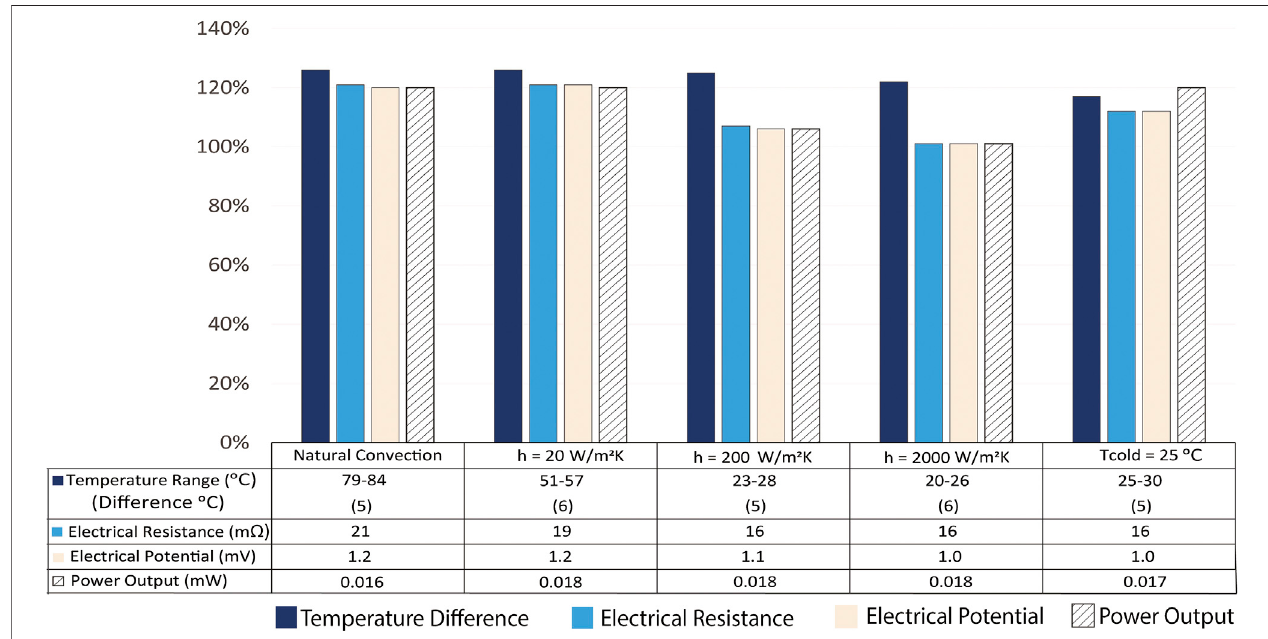
FIGURE 9 | The change in performance for the hourglass leg shape for various cold side boundary conditions (natural convection, forced convection coef fi cients h (cid:1) 20,200,and 2,000 W/m 2 -K,andconstantcoldsidetemperature T c (cid:1) 25,800 C)andconstanthotsideheat fl ux( Q h ” ).Thepercent changeinthetemperaturerange acrossthehourglassleg,legelectricalresistanceandpotential,andmaximumpowergenerationpotentialcomparedtothoseforarectangular(conventional)shapedleg are shown for (Bi 0.5 Sb 0.5 ) 2 Te 3 ( Q h ” (cid:1) 625 W/m 2 ). The trends for Si 0.78 Ge 0.22 ( Q h ” (cid:1) 10,000 W/m 2 ) are the same. The table below the plot shows the computed values of the performance